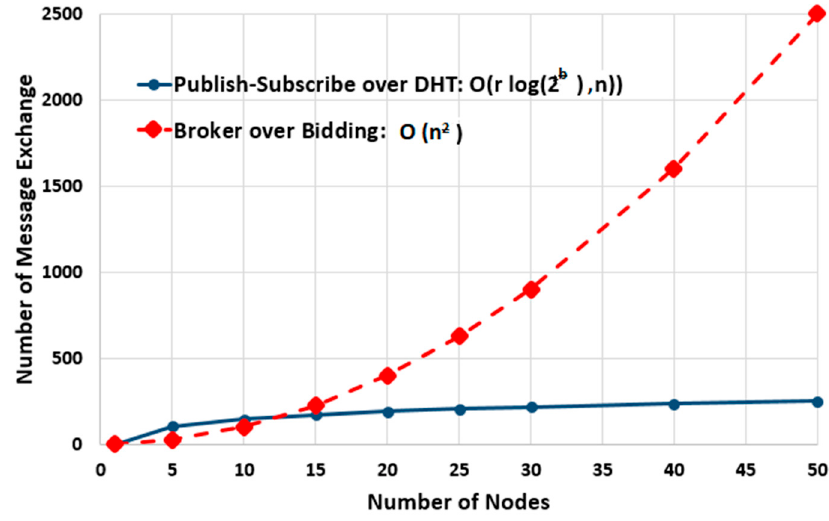
Figure 2. A comparison between two agent technologies’ complexity using message count metrics values: publish-subscribe and bidding algorithm.